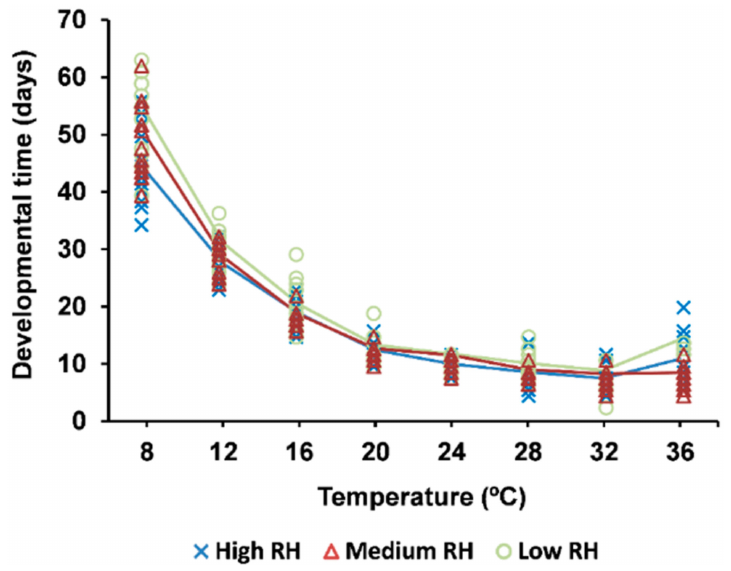
Figure 2. The egg developmental time of Hypera postica at different temperatures and relative humid- ity (RH) conditions (high: 90% < RH < 100%; medium: 50% < RH < 75%; and low: 10% < RH < 35%).